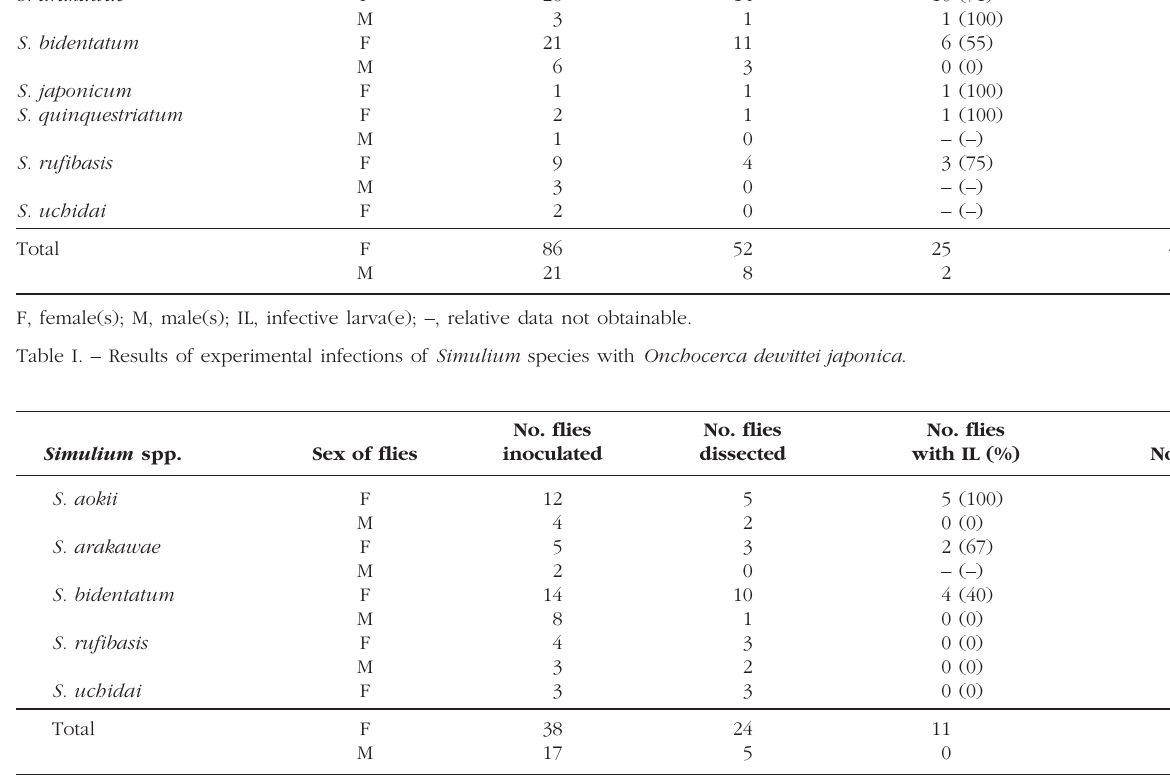
Table II. – Results of experimental infections of Simulium species with Onchocerca sp. from wild boar.